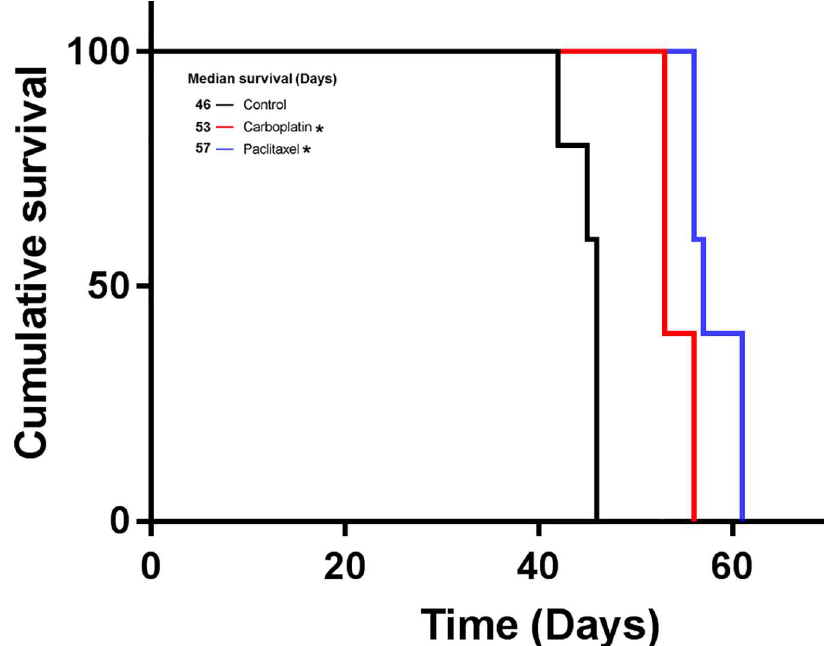
Fig 4. Mice survival in the OE19 peritoneal dissemination model treated with carboplatin and paclitaxel. 10X10 6 OE19 cells were injectedintraperitoneally in SCID mice and treatment started after 2 weeks and continuedfor another 2 weeks. The curve representsthe animal survival time from the day of implantation. * Representssignificantdifferencescompared with control (vehicle) at p = 0.0034.